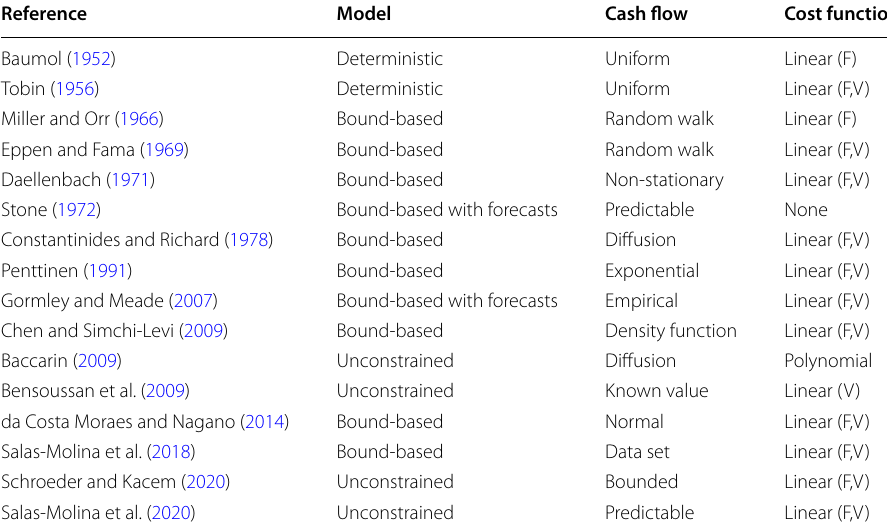
fixed; V Variable = =